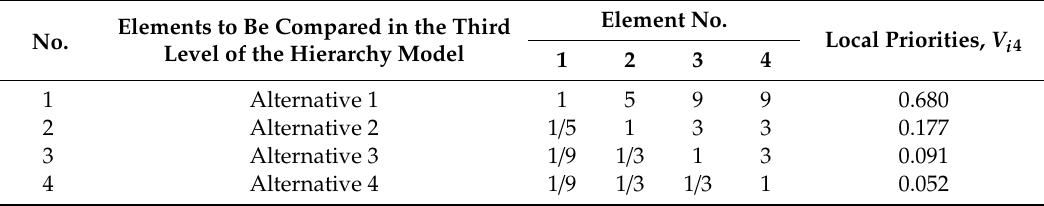
Table 9. Matrix of pairwise comparisons for the elements of the third level by the criteria “social fare”. Elements to Be Compared in the Third No. Level of the Hierarchy Model